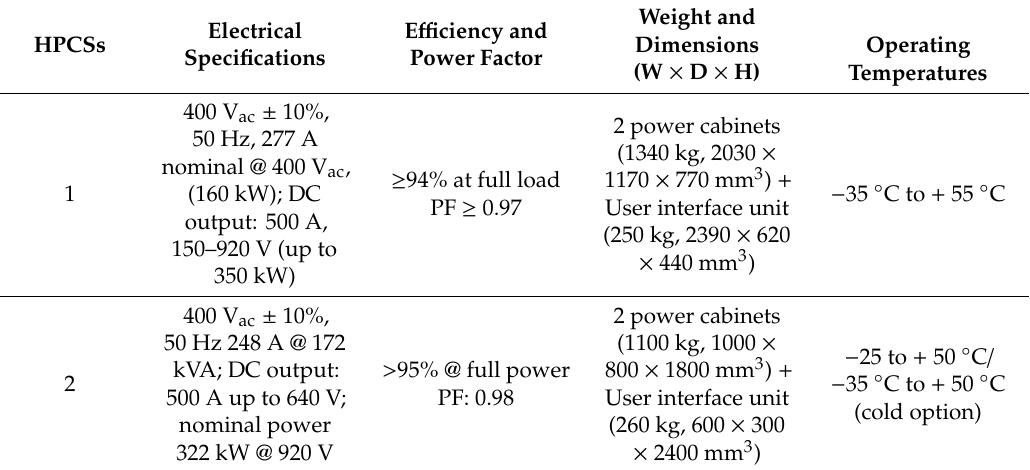
Table 1. HPCS main Table 1. HPCS main specifications.